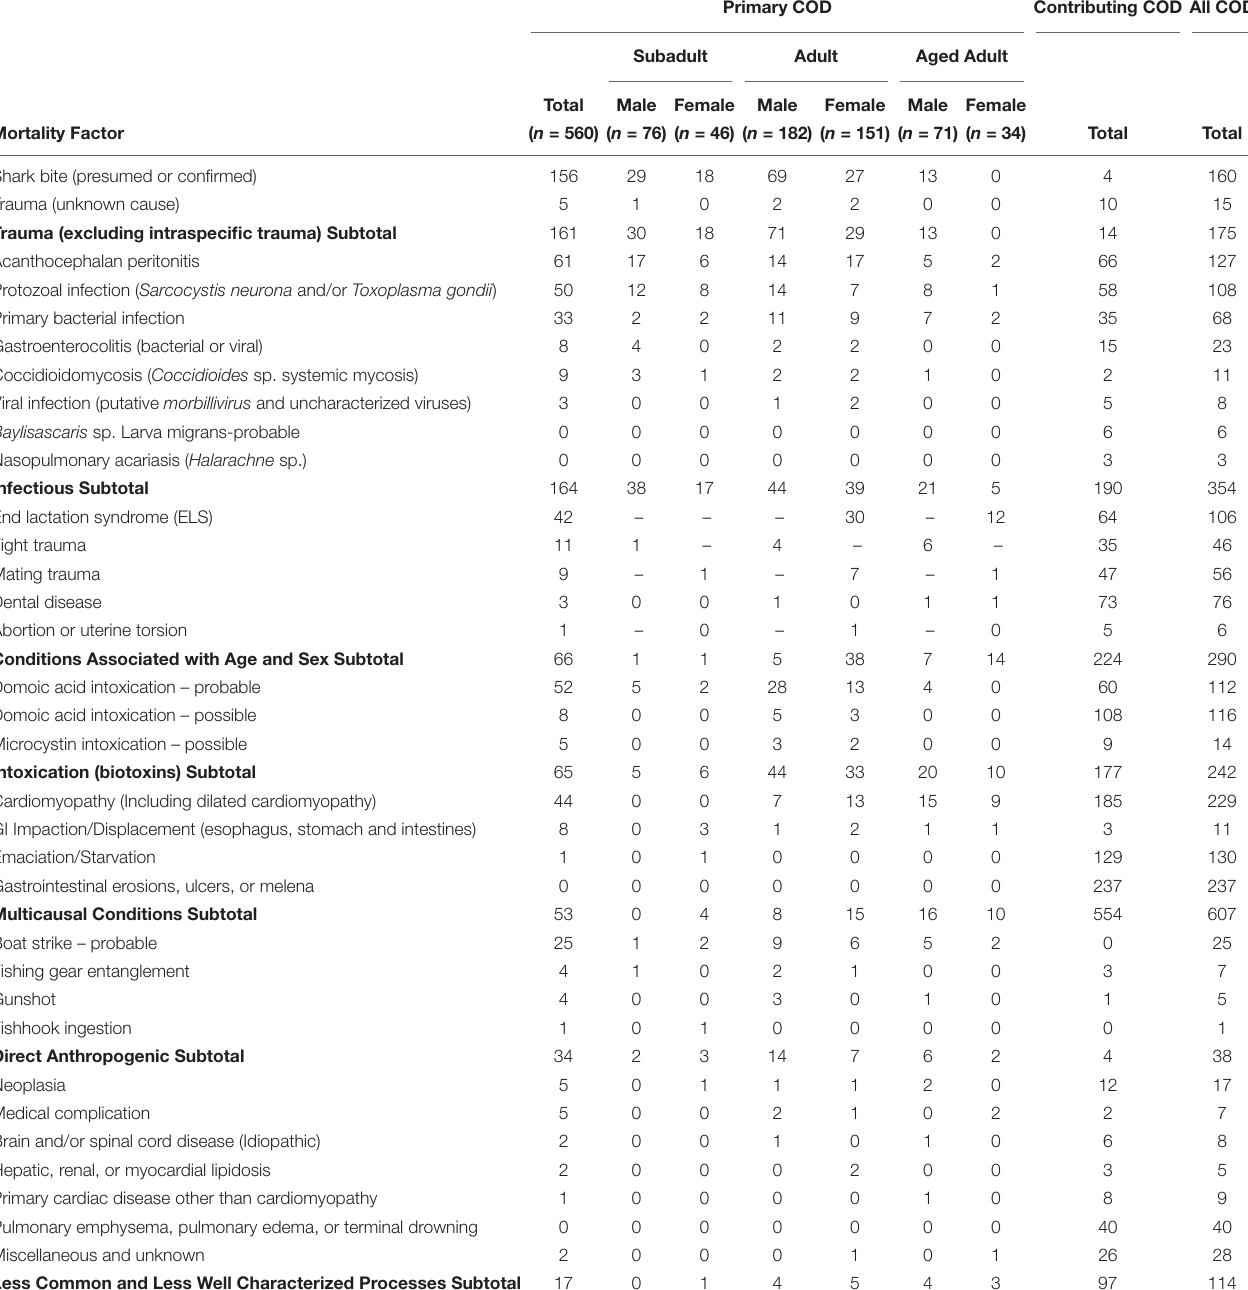
TABLE 2 | Combined primary and contributing causes of death (COD) for 560 necropsied southern sea otters ( Enhydra lutris nereis ) examined